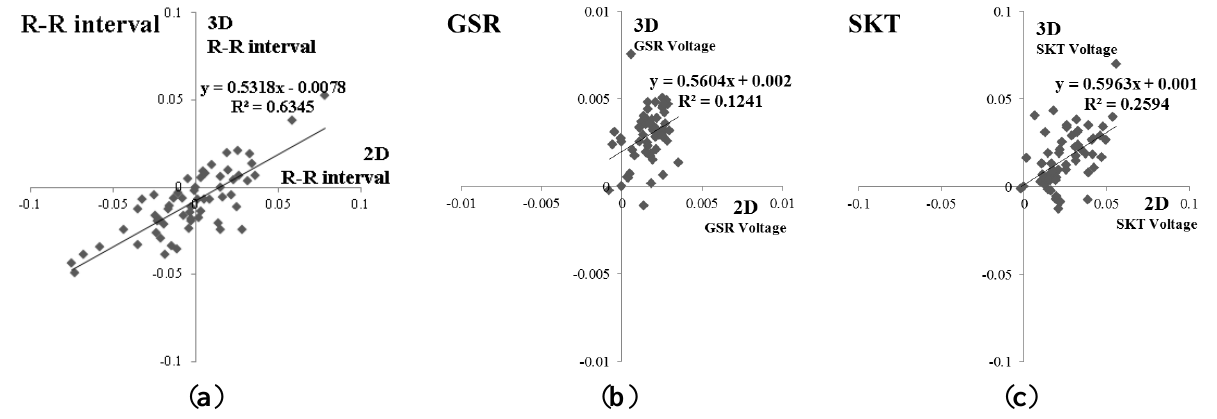
Figure 6. Correlational analyses of two dimensional feature distributions of 2D and 3D responses vs. time. ( a ) R-R interval; ( b ) GSR; ( c )